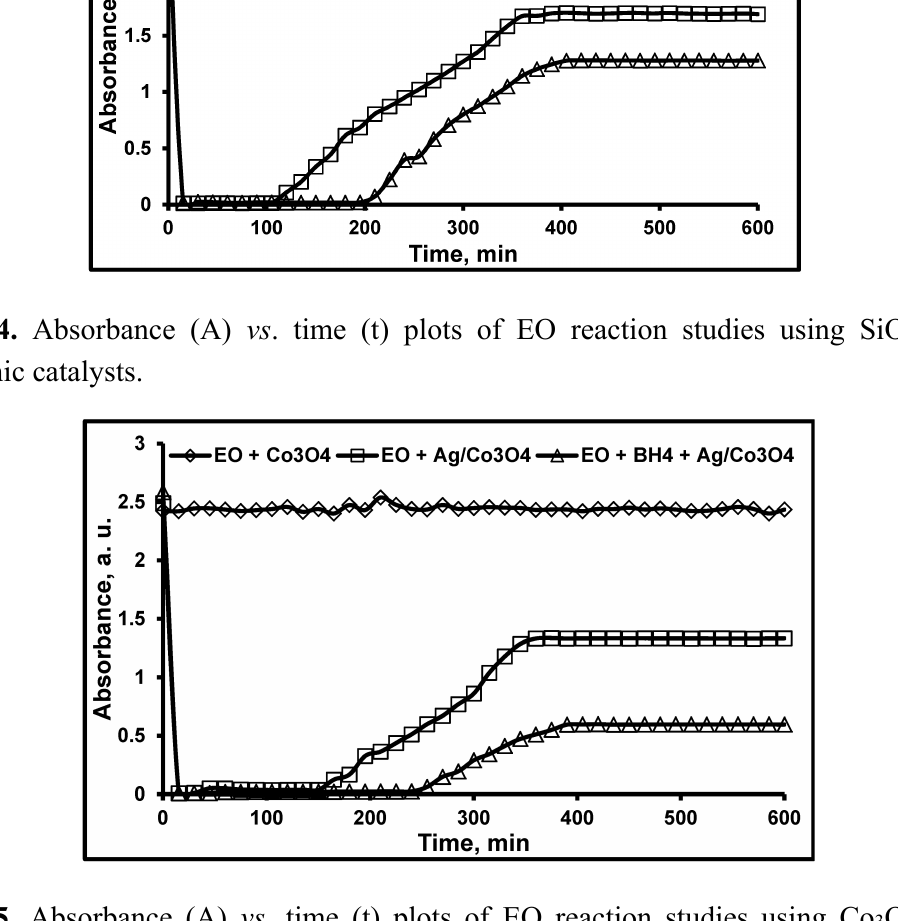
Figure 5. Absorbance (A) vs . time (t) plots of EO reaction studies using Co 3 O 4 -based monolithic